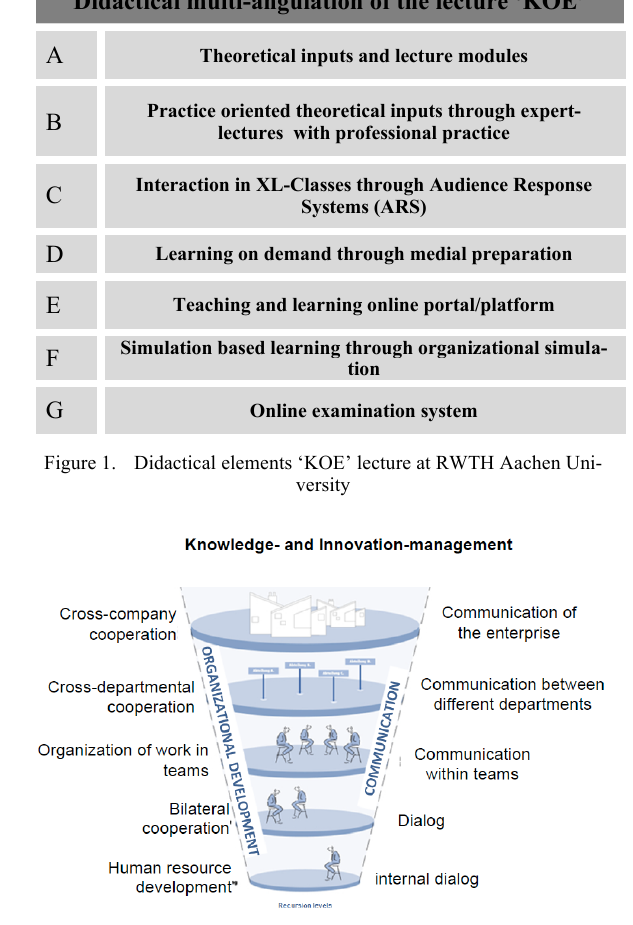
Figure 2. ‘KOE’ funnel/recursion-layers